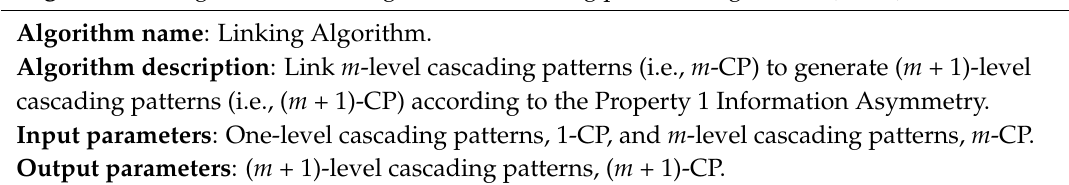
Algorithm 2. Algorithm of linking m -level cascading patterns to generate ( m + 1)-level ones. Algorithm name : Linking